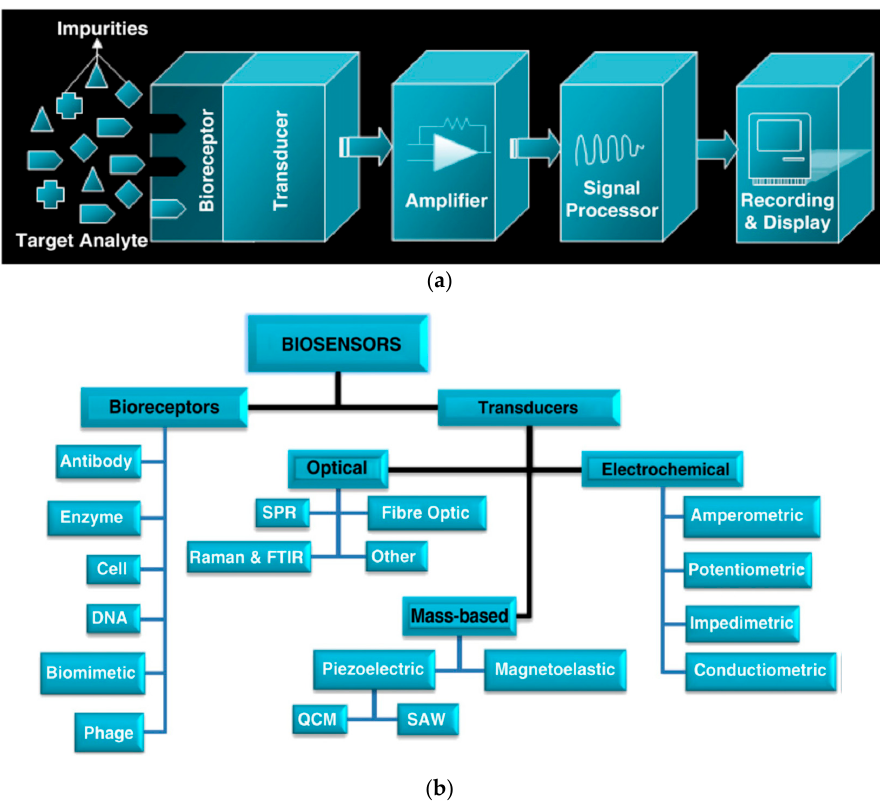
Figure 6. ( a ) Stages of a biosensor; and ( b ) classification of biosensors for different transducers [20].